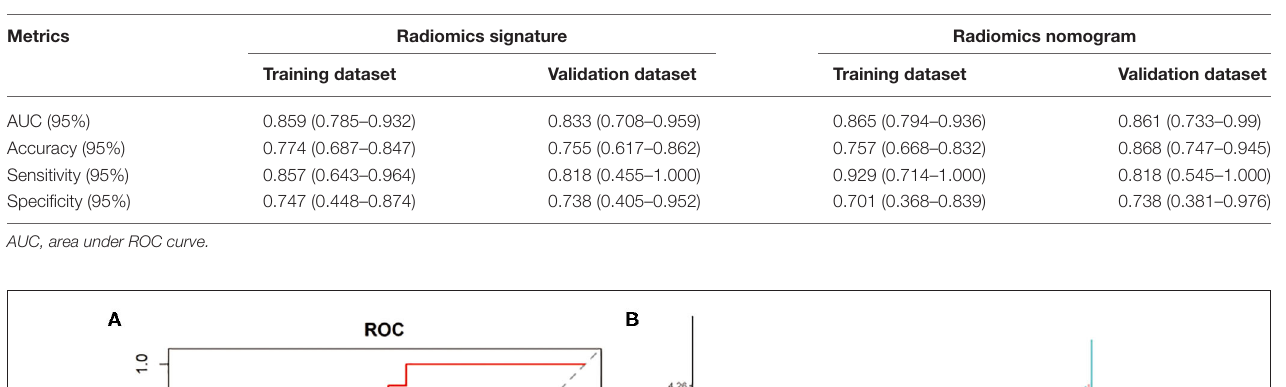
TABLE 2 | Performance of the radiomics signature and nomogram.